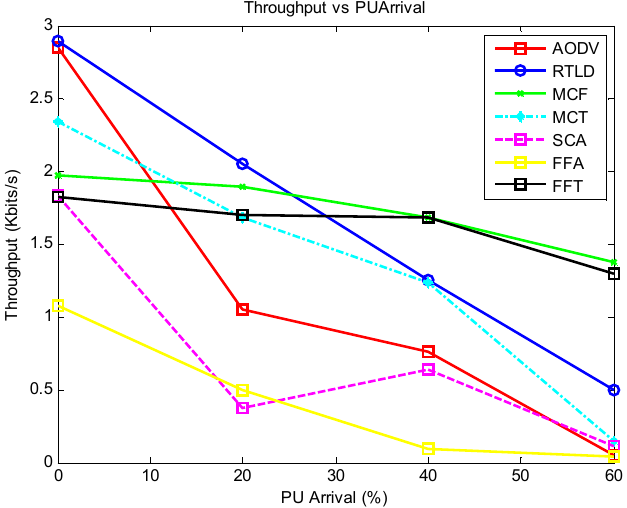
Figure 4. Throughput performance of all protocols versus primary user activity.